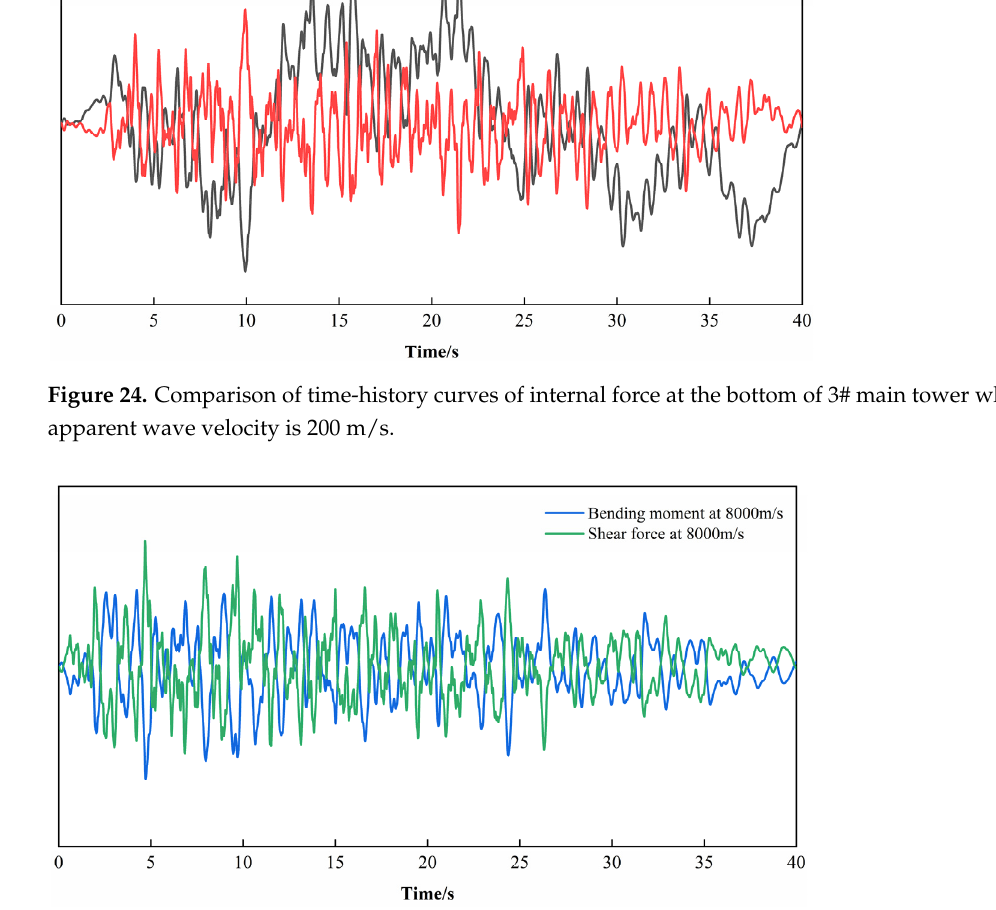
Figure 25. Comparison of time-history curves of internal force at the bottom of 3# main tower when apparent wave velocity is 8000 m/s.